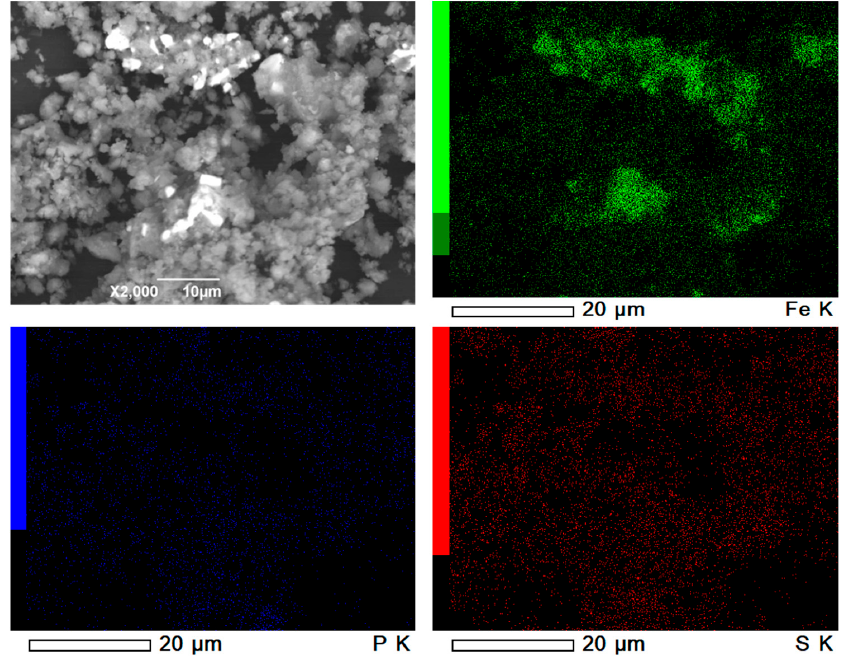
Figure 13. SEM image (BEC) of the roasted RM with the distribution of S, P and Fe at T = 1000 °C, t = 30 min, 13.65% Na 2 SO 4 .